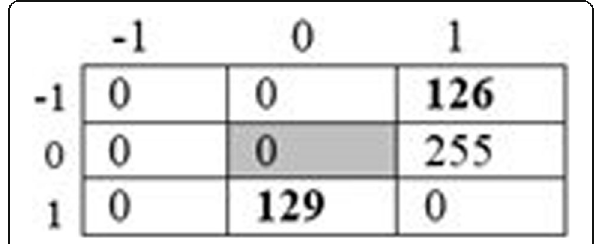
Fig. 3 Example of corrupted image segment for case 2 of case A